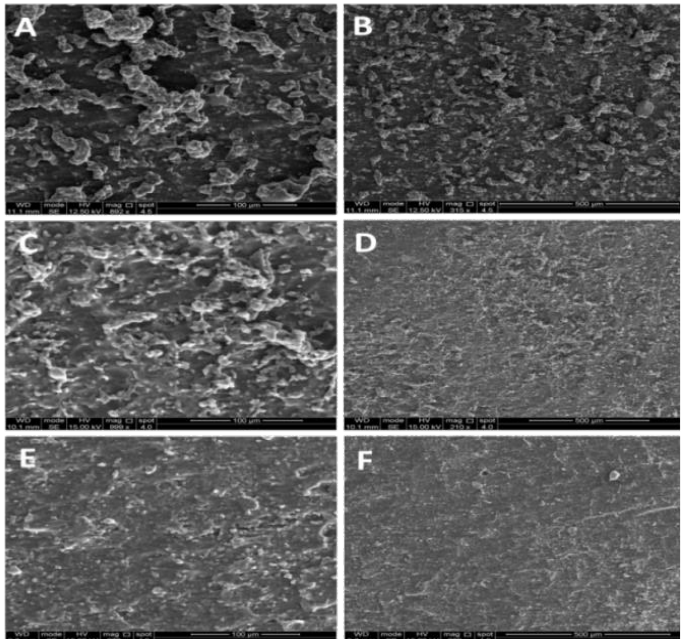
Figure 7: Scanning electron microscope results: control group(A,B), 2% group of KAL(SO 4 ) 2 (C,D), 3% group of KAL(SO 4 ) 2